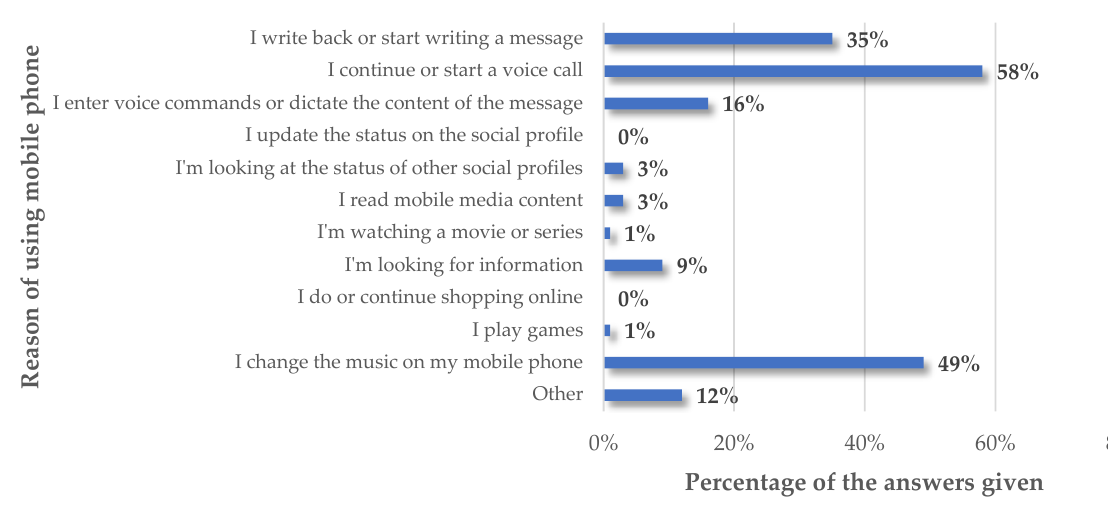
Figure 1. Typical purposes of using the phone as a driver while traveling.